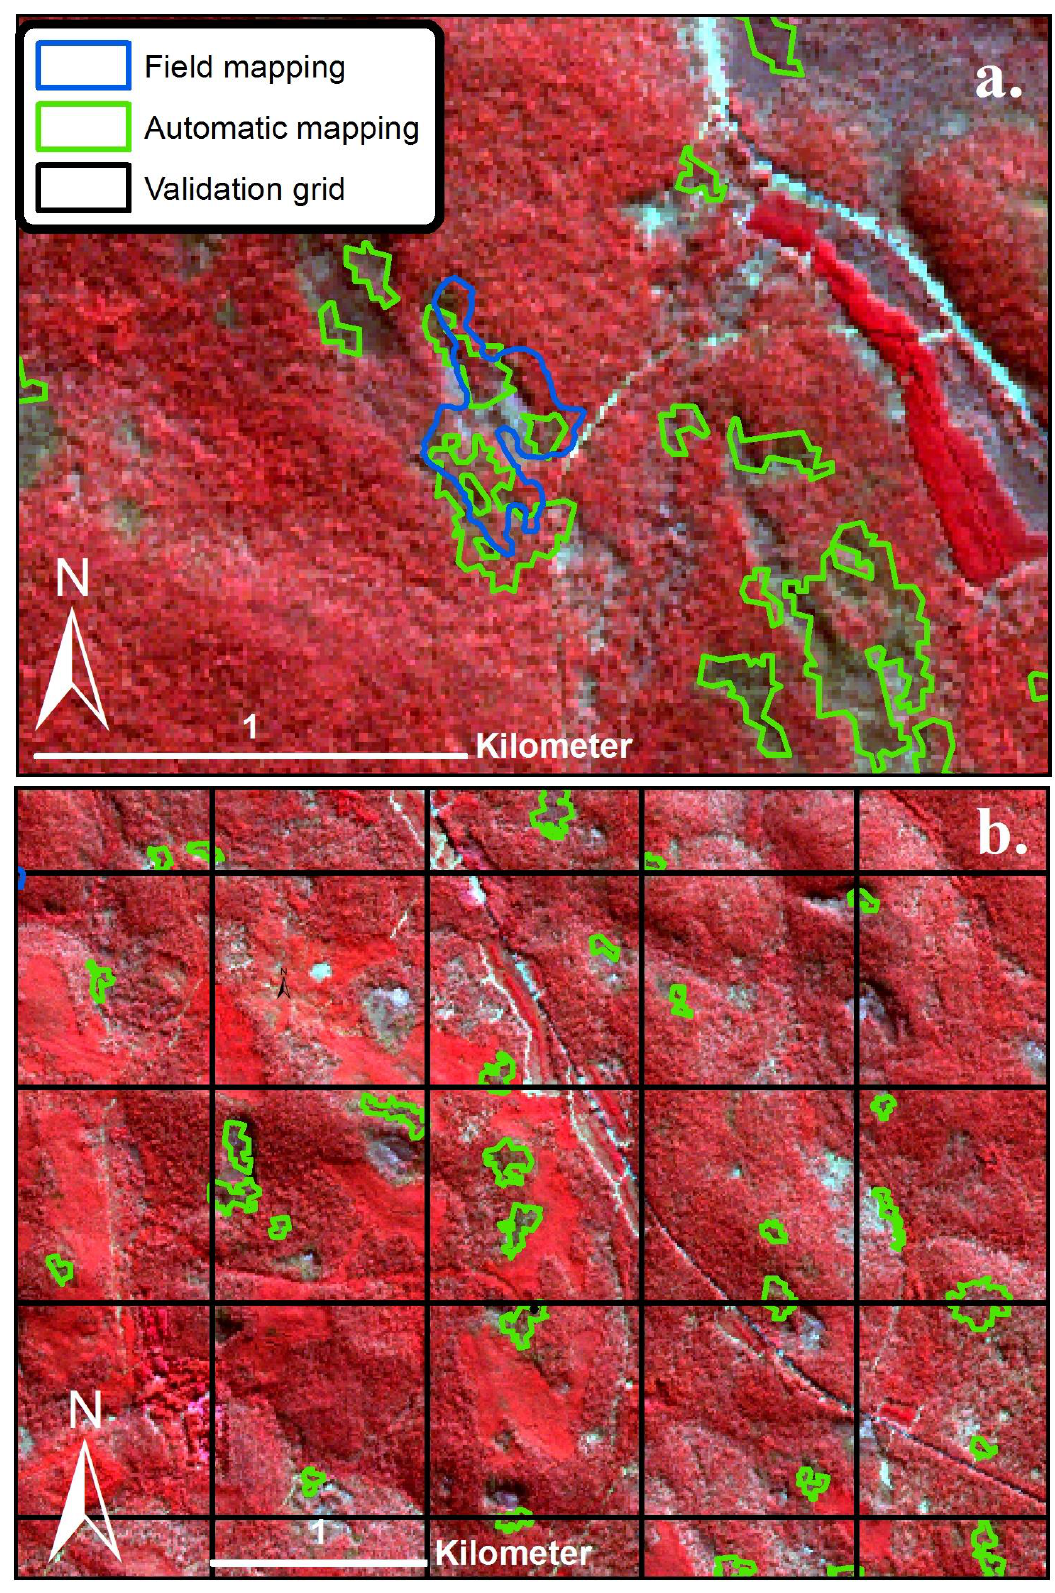
Figure 2. Système Pour l'Observation de la Terre mission 5 (SPOT-5) infrared imagery (10 m) overlaid with ( a ) field data and feature extraction modeled patches of mortality (POM) and ( b ) the model evaluation grid and POM contained within a number of